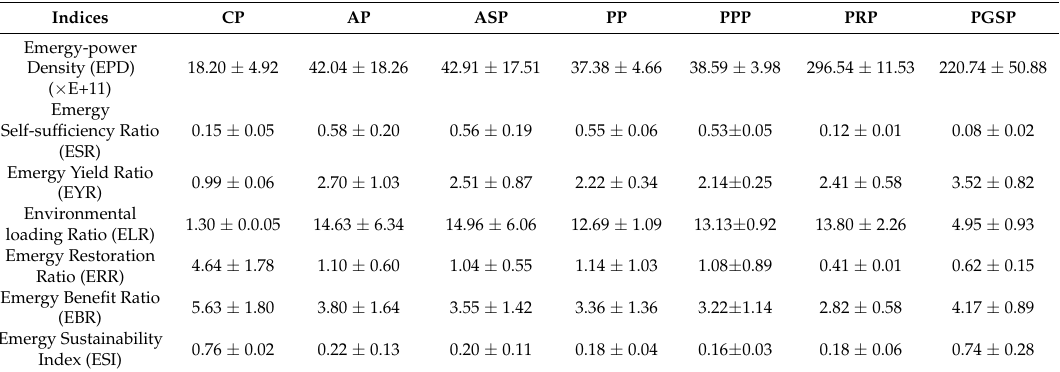
Table 4. Emergy evaluation in the seven agroforestry planting